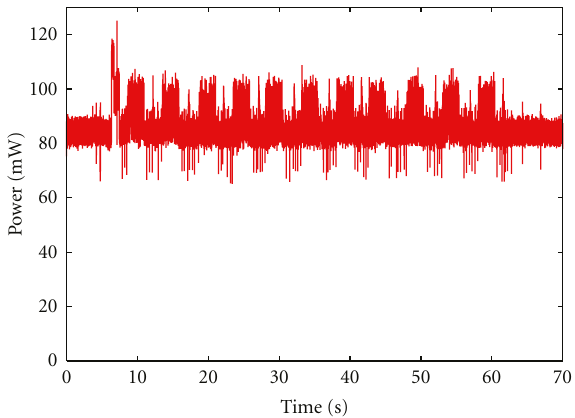
Figure 7: Power consumption trace when transfering program “Pong” using